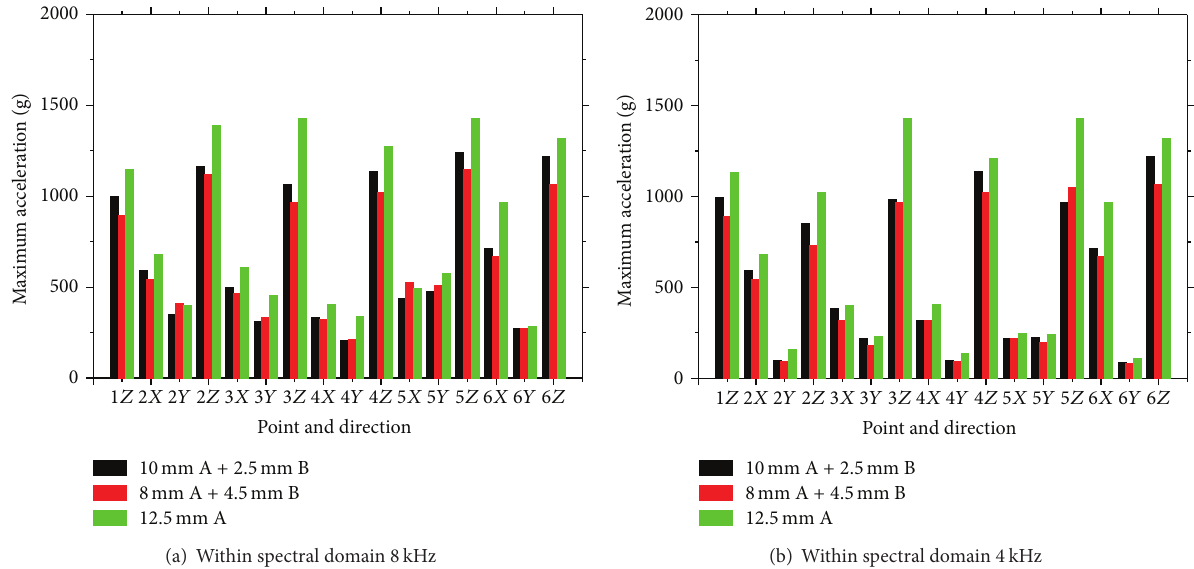
Figure 5: Contrasts of maximum acceleration at different points and directions.